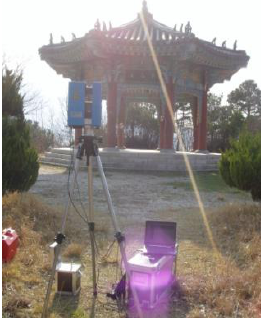
Figure 2. Data acquisition scene